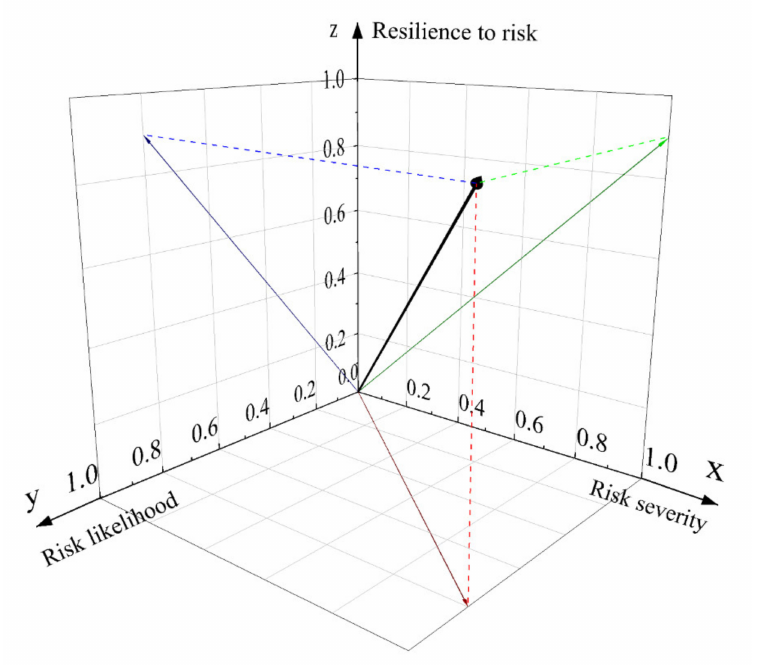
Figure 5. The constructed three-dimensional continuous risk